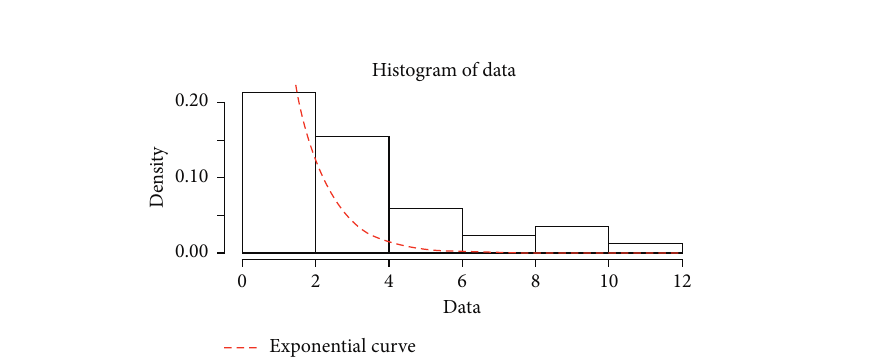
Figure 1: Histogram of serious cases of infected COVID-19 virus